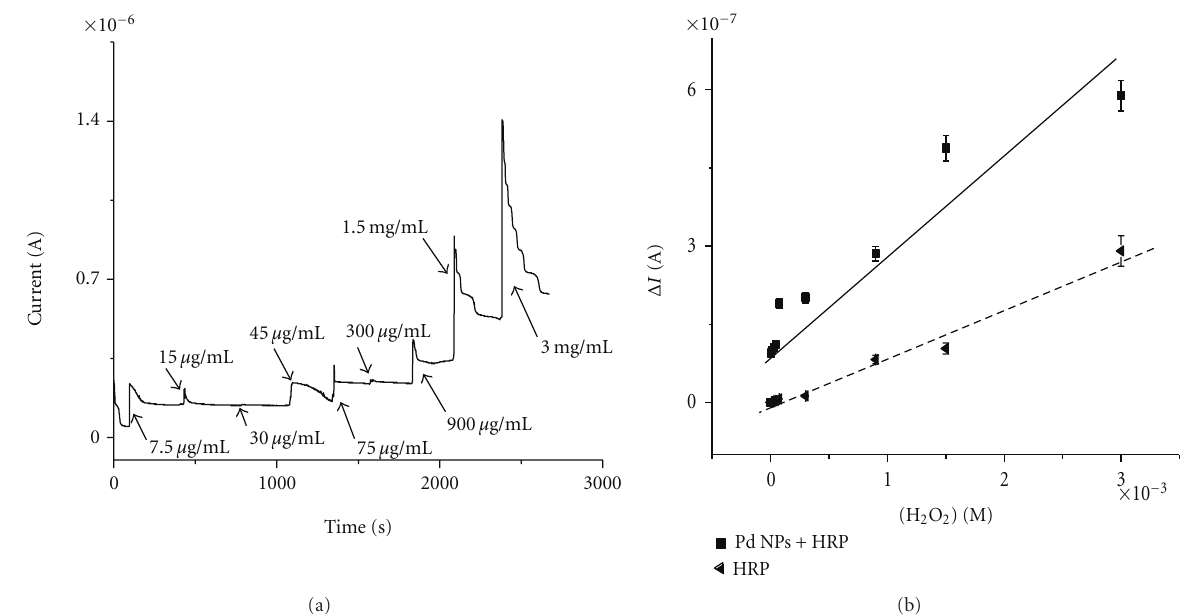
Figure 3: (a) Chronoamperometry curve of gold electrode with thiol acid and with Pd NPs and with HRP. (b) Calibration curve of gold electrode with thiol acid and Pd NPs and HRP (squares) and gold electrode with thiol acid and HRP and BSA (triangles) with di ff erent concentrations of H 2 O 2